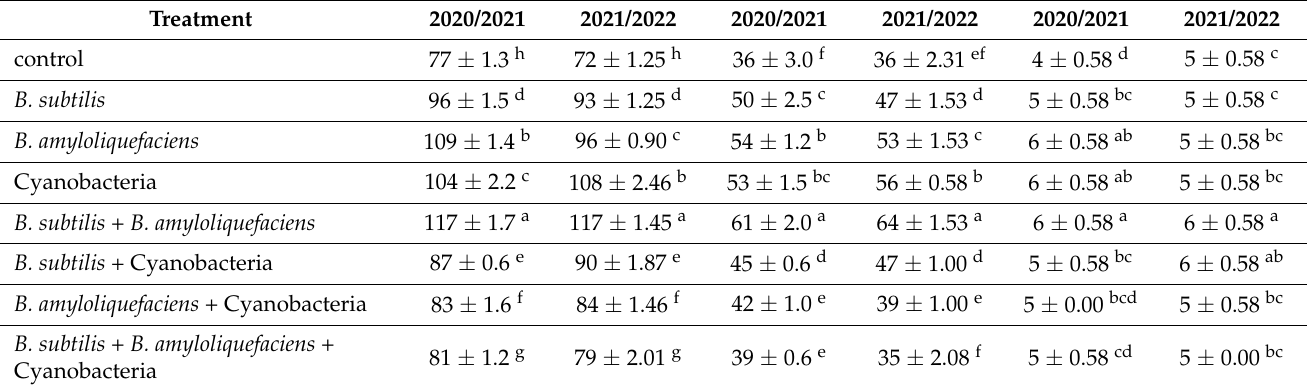
Table 1. The effect of inoculation with two PGPR strains ( B. subtilis and B. amyloliquefaciens ) and cyanobacteria on the yield parameters of tomato plants in two seasons (2020/2021) and (2021/2022). Different letters indicate significant differences between treatments (ANOVA, LSD, p < 0.05). Error bars represent standard error of the